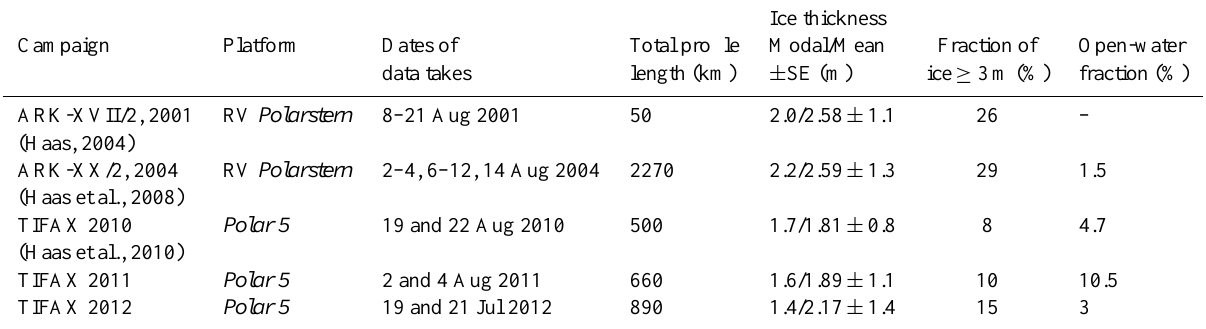
Table 1. The table summarizes for the area of interest and individual campaigns the dates of observations, platform, total profile length, the ice thickness (mode and mean ± SE), as well as the fraction of ice thicker than 3m and the open-water fraction along profiles. Ice thickness Campaign Platform Dates of Total profile Modal/Mean Fraction of Open-water data takes length (km) ± SE (m) ice ≥ 3m (%) fraction (%) ARK-XVII/2, 2001 RV